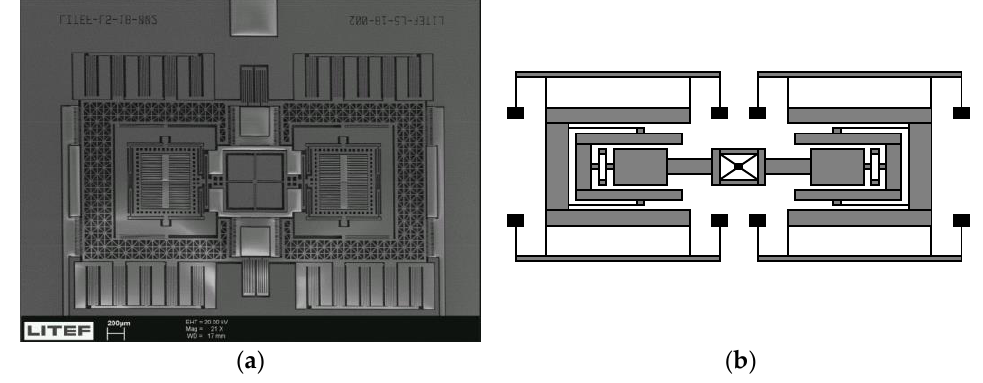
Figure 4. Gyroscope Design: ( a ) SEM image showing the dual mass Lin-Lin-structure with rotational spring; ( b ) Mass-suspension scheme.